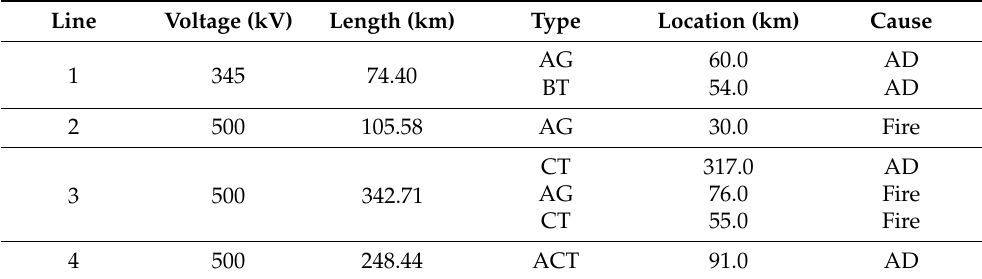
Table 11. Characterization: real fault scenarios.